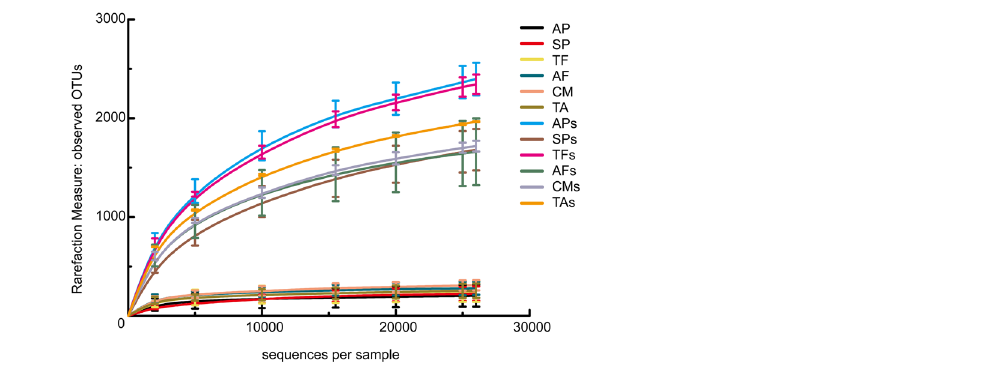
Figure 2. Rarefaction curves of observed OTUs (operational taxonomic units, OTUs) at 97% similarity. The average values of three replicates are shown for each sample including the standard error therein. AP, SP, and TF represented the endophytic bacteria of three species of ectomycorrhizal fungi, respectively, and APs, SPs, and TFs represented the bacteria of corresponding hyphosphere soils of ectomycorrhizal fungi, respectively. AF, CM, and TA represented the endophytic bacteria of three species of saprophytic fungi, respectively, and AFs, CMs, and TAs represented the bacteria of the corresponding hyphosphere soils of saprophytic fungi.